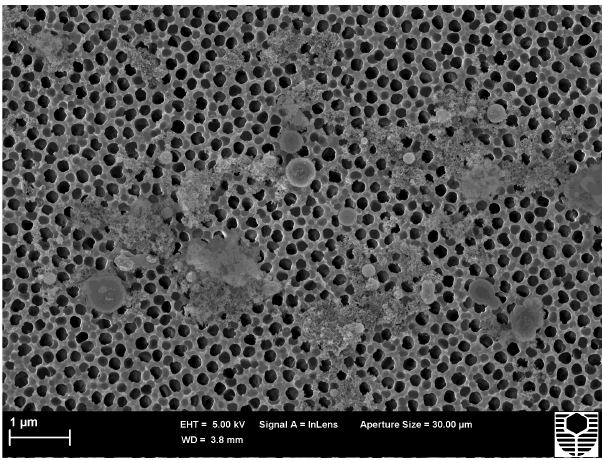
Figure A1. SEM image of Anopore filter after filtering 1L of ice core melt water, and backflushing the filter to remove filtered parti-